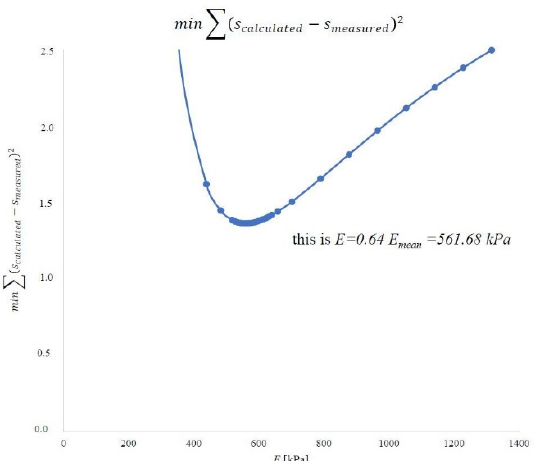
Figure 23. According to the second method, the representative value of the constrained modulus of elasticity of the peat material on the island of Ostrów Brdowski in Szczecin.